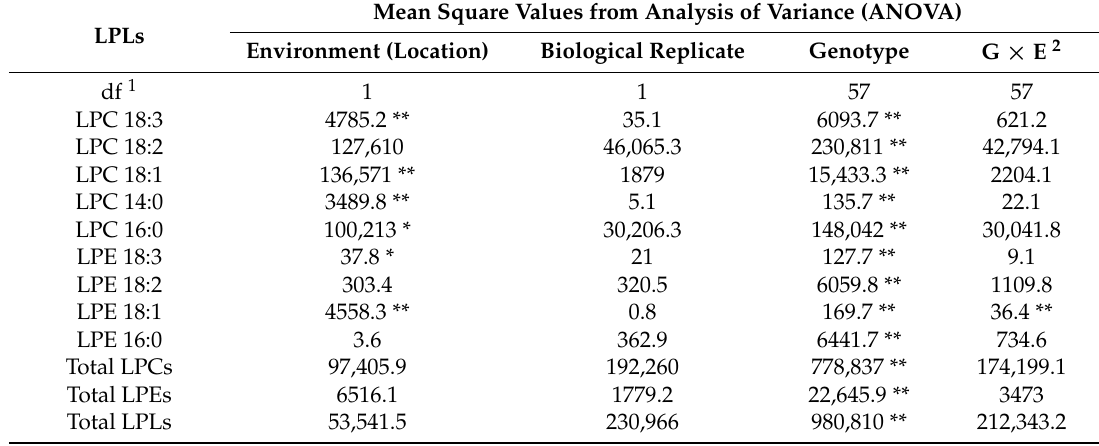
Table 2. Variance analysis of wheat LPLs of 58 cultivars in two locations. Mean Square Values from Analysis of Variance (ANOVA)